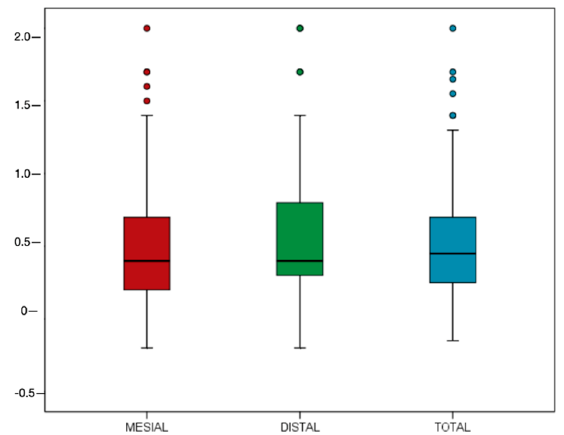
Figure 2. Marginal bone loss measured on the mesial and distal sides and mean of both sides. Table 3. Association between total MBL and independent variables of patient profile, surgery, and implant characteristics: Wald chi [2] test results of the general linear regression model.